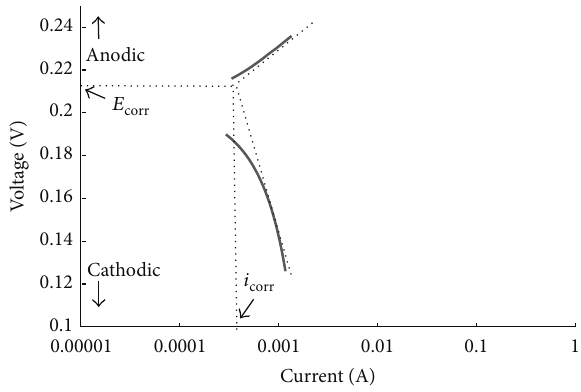
Figure 1: Polarization curves for iron in a quiescent solution of 0.6 M NaCl open to the air. The anodic and cathodic branches are pointed in the plot. In addition, the slopes of the anodic and cathodic branches along with interpolation of the two branches are also extracted using the dotted line. Based on this extraction, the 𝑖 𝐸 corr and corr values are also